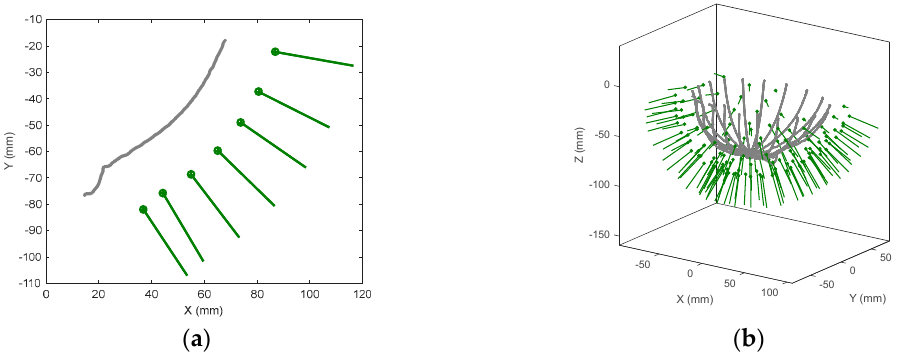
Figure 4. Laser outline for ( a ) a single azimuth; and ( b ) an entire scan of a volunteer breast and the calculated antenna locations shown as line and dots representing the antenna orientation and aperture location respectively.